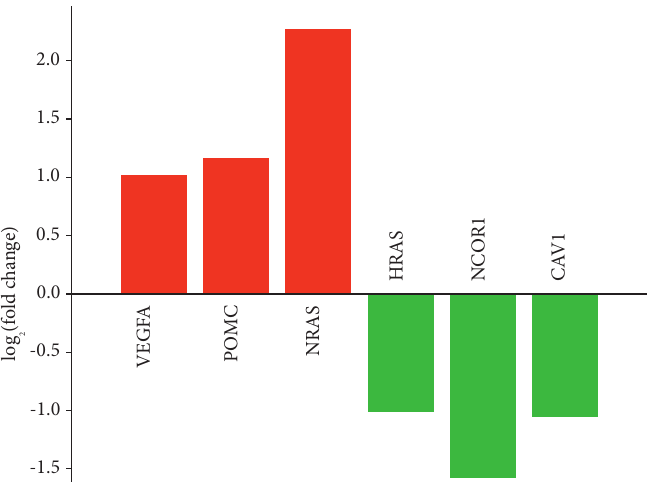
Figure 6: Hub gene expression analysis. Red stands for upregulated genes, and green stands for downregulated genes in exercise samples based on